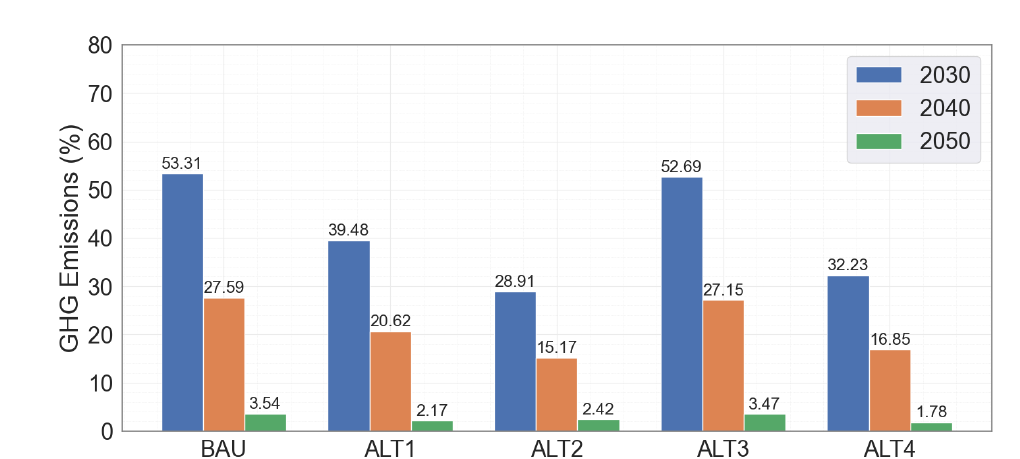
Figure 16. Comparison of the evolution of GHG emissions between alternatives for the residential sector (%).